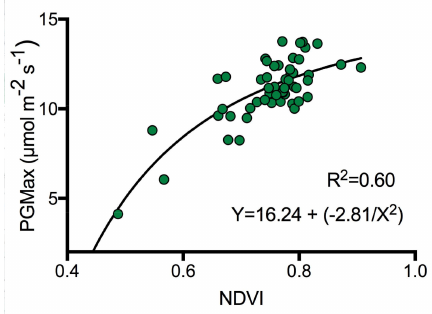
Figure 4. Relationship between normalized difference vegetation index (NDVI) and PGmax ( µ mol m − 2 s − 1 ) for 15 plots over four sampling dates (July–August